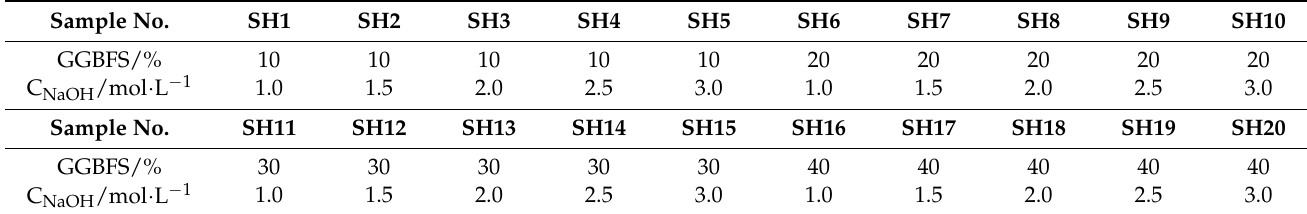
Table 4. Single activator mix ratio design table.